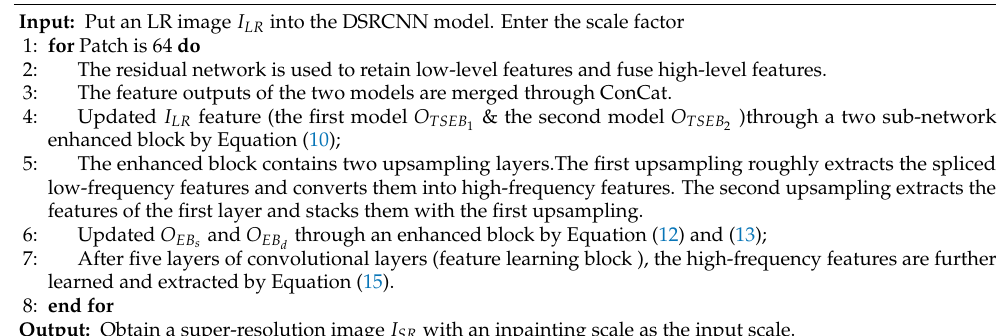
Algorithm 1 The process of converting an LR image into an SR